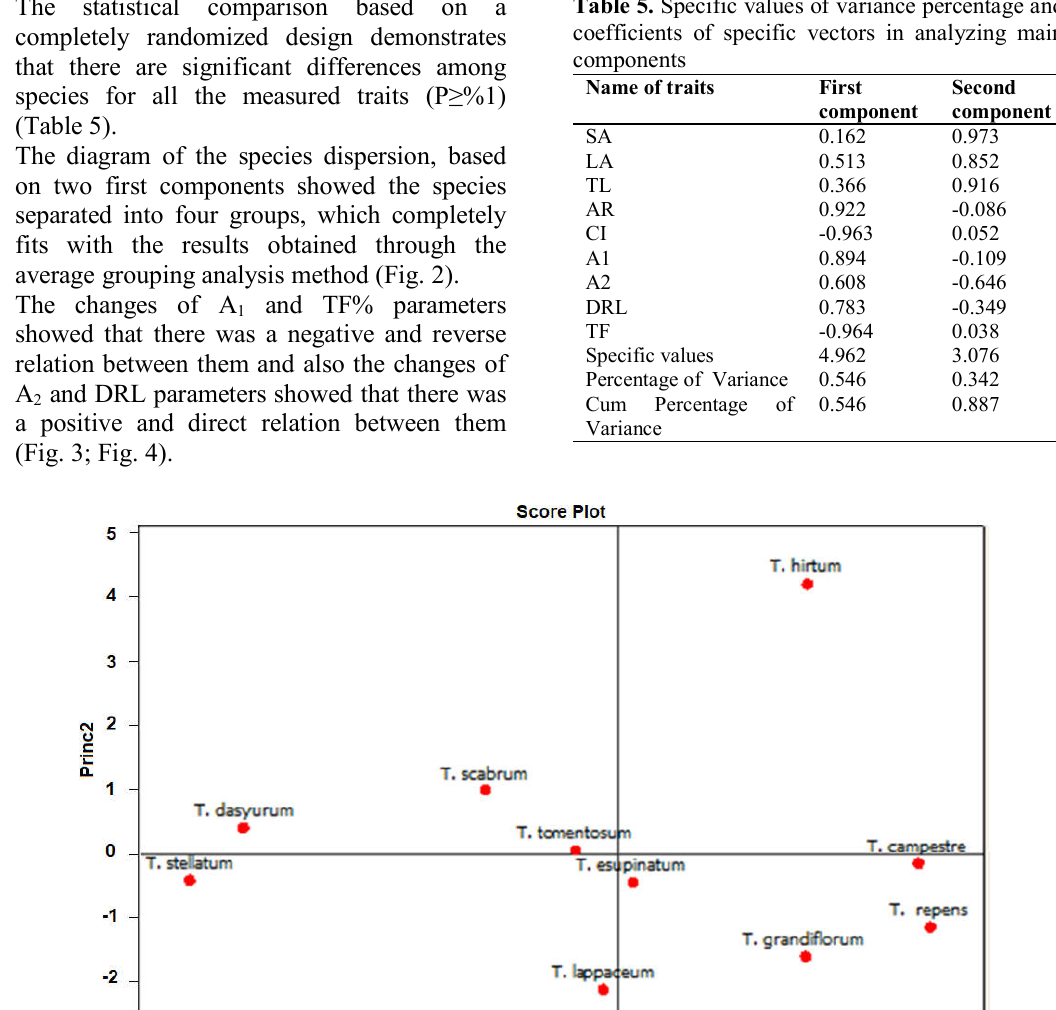
Mean of squares